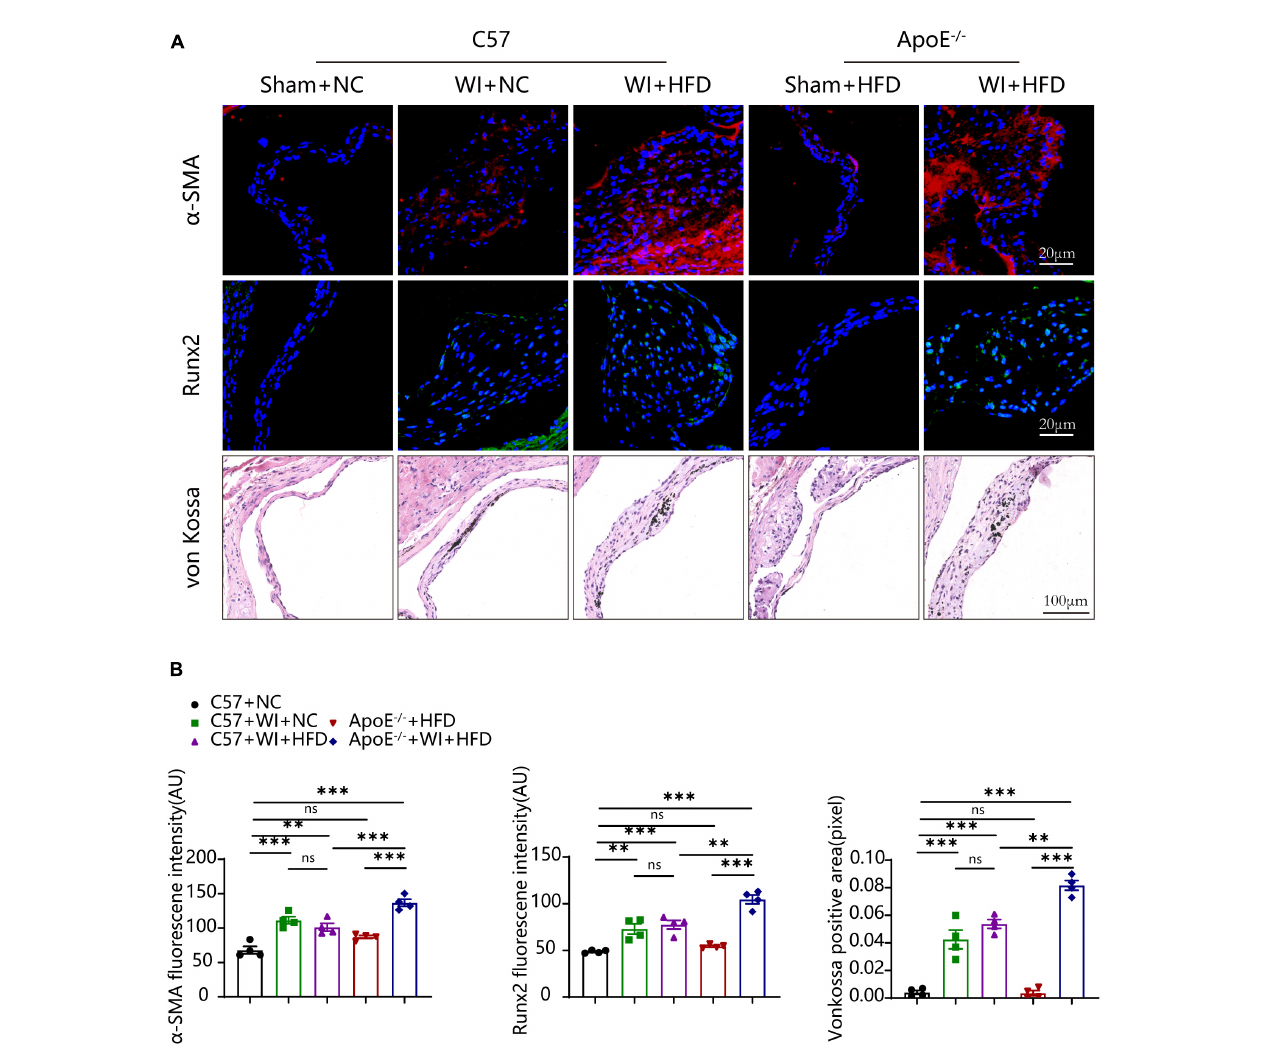
FIGURE6 Hyperlipidemia augmented advanced myofibroblast activation and Osteogenic reaction. (A) Representative images of α -Smooth muscle actin ( α -SMA, red, scale bar, 20 µ m), Runx2 (green, scale bar, 20 µ m) immunostaining and von Kossa (scale bar, 100 µ m) of aortic valves 8 weeks after wire injury and quantification of immunofluorescent data, n = 4 per group. Higher expression of α -SMA and Runx2 were observed in hyperlipidemic mice after wire injury. (B) Quantitative analysis of α -SMA, Runx2 immunofluorescent, and von Kossa positive area data, n = 4 per group. Results are mean ± SEM. Adjusted P values were provided in case of multiple groups. ns. indicates non-significant P value. ** P < 0.01 and *** P <